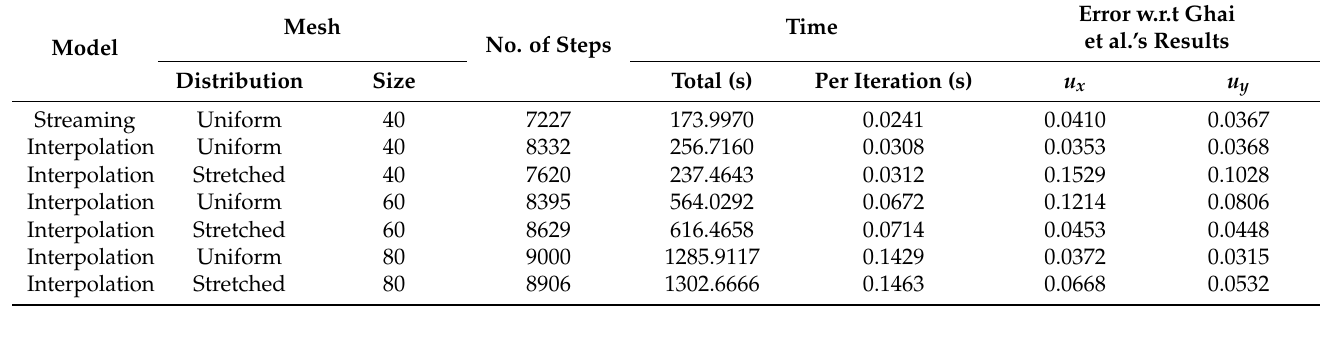
Table 3. Error and computational cost of the 2D lid-driven cavity problem.